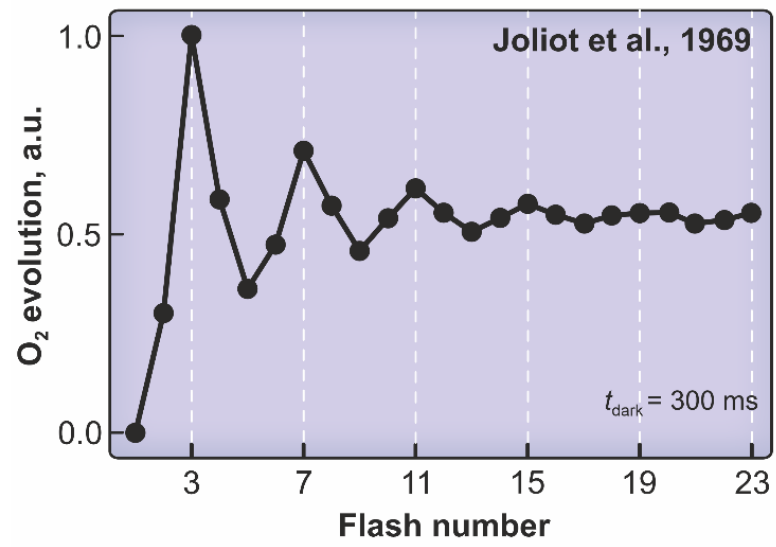
Figure 2. Yield of molecular oxygen from Chlorella cells as a function of flash number. The first flash does not result in any oxygen; the first maximum comes on the third flash. Thereafter, maxima occur on every fourth flash, and the oscillation gradually decreases towards a flat line (steady state). Redrawn and modified from Joliot et al. [4]. Kok et al. [5] obtained very results with spinach chloroplasts. (See also Joliot & Kok [11]).